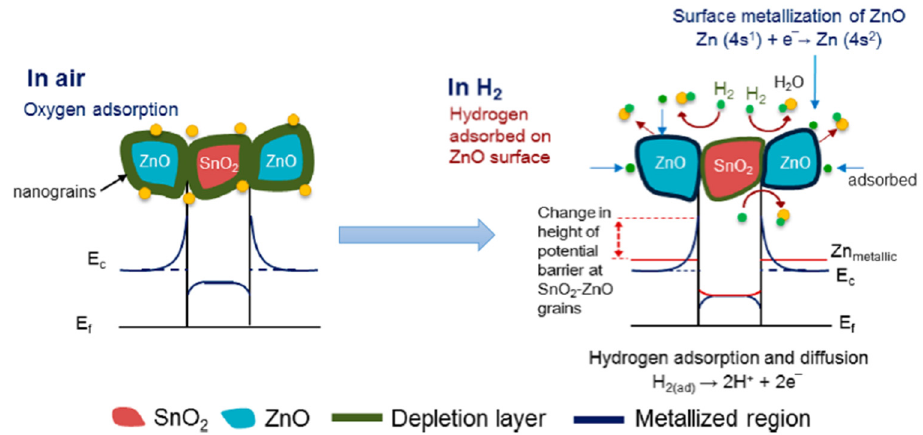
Figure 33. The schematic diagram for explanation of sensing mechanism of ZnO-SnO 2 heterojunc- tion [140]. Copyright (2015), with permission from American Chemical Society.